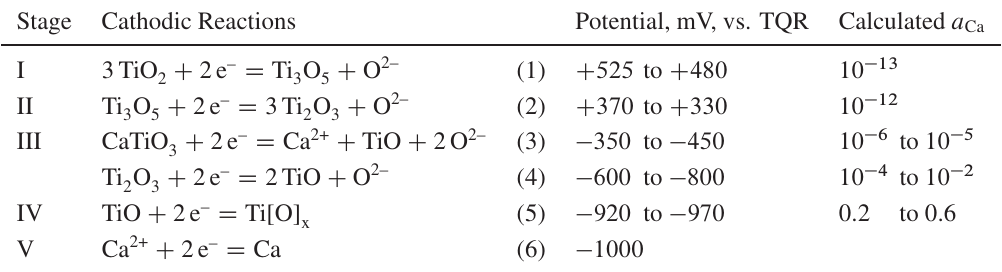
obtained by cyclic voltammetry 2